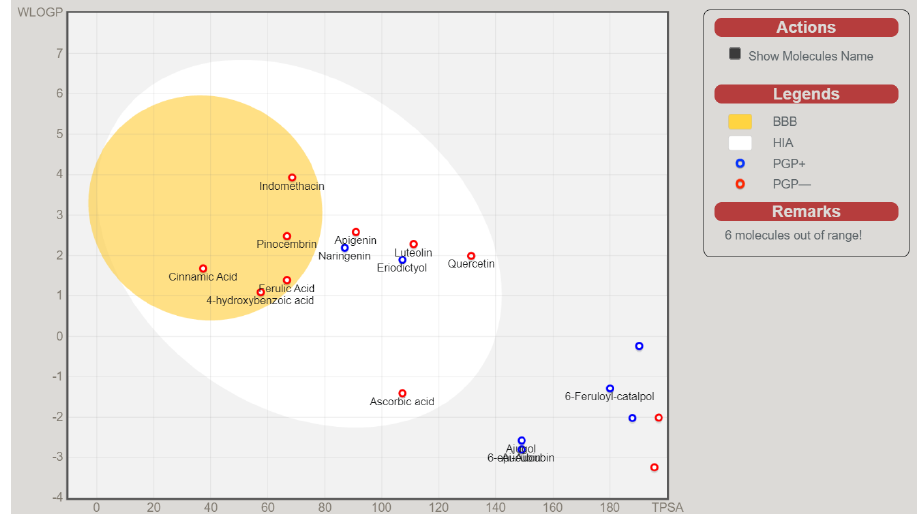
Figure 6. SwissADME BOILED – Egg diagram of the bioactive compounds from Crescentia cujete and positive controls Indomethacin (anti-inflammatory) and Ascorbic acid (antioxidant) for perceptive evaluation of their passive gastrointestinal absorption (HIA) and blood-brain barrier (BBB)